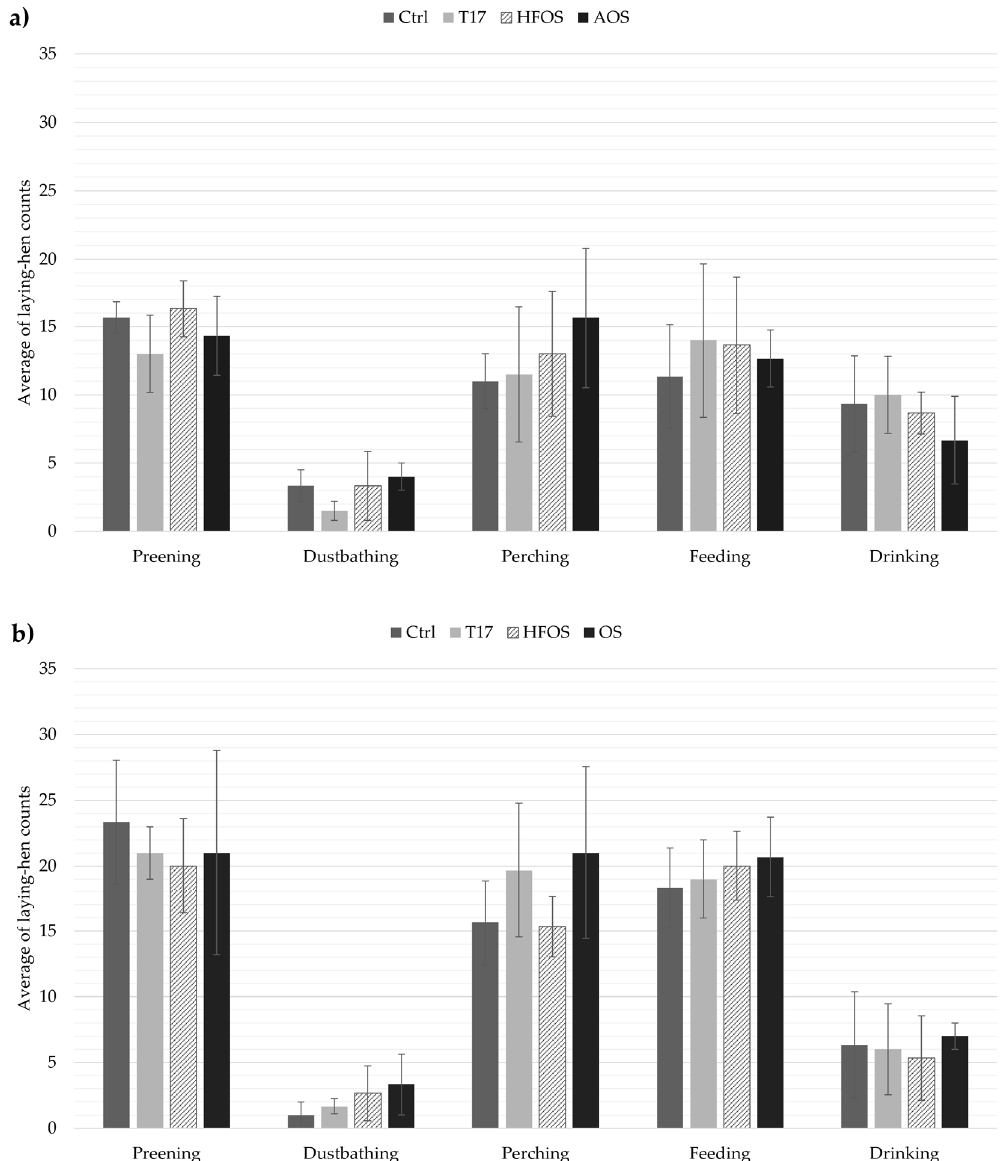
Figure 4. Average counts of laying hens displaying the five natural behaviors with standard deviations. ( a ): Batch 1; ( b ): Batch 2. Ctrl = traditional aviary system. T17 = decrease of litter surface area. HFOS = use of heated floor with oil sprinkling periods. AOS = use of biochar material with oil sprinkling periods. OS = oil sprinkling periods.